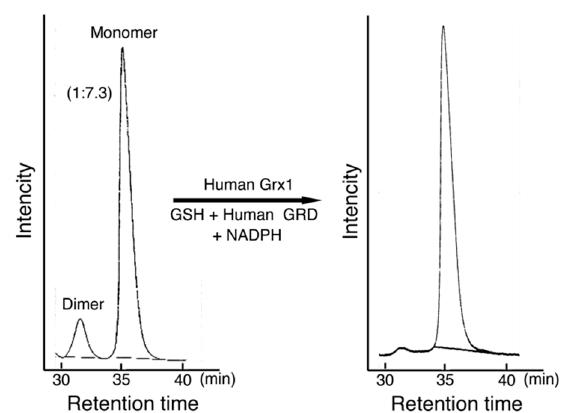
Figure 6. Probable activation mechanism of MST in the Grx-GSH-GRD-NADPH reducing systems. Box: The reducing system contains Grx without Grx, GRD, and NADPH. Details are described in the text.